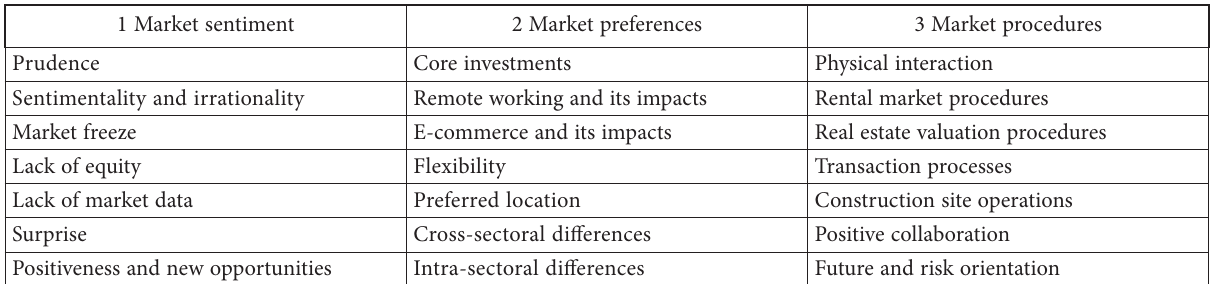
Table 3. Categorization of the interview